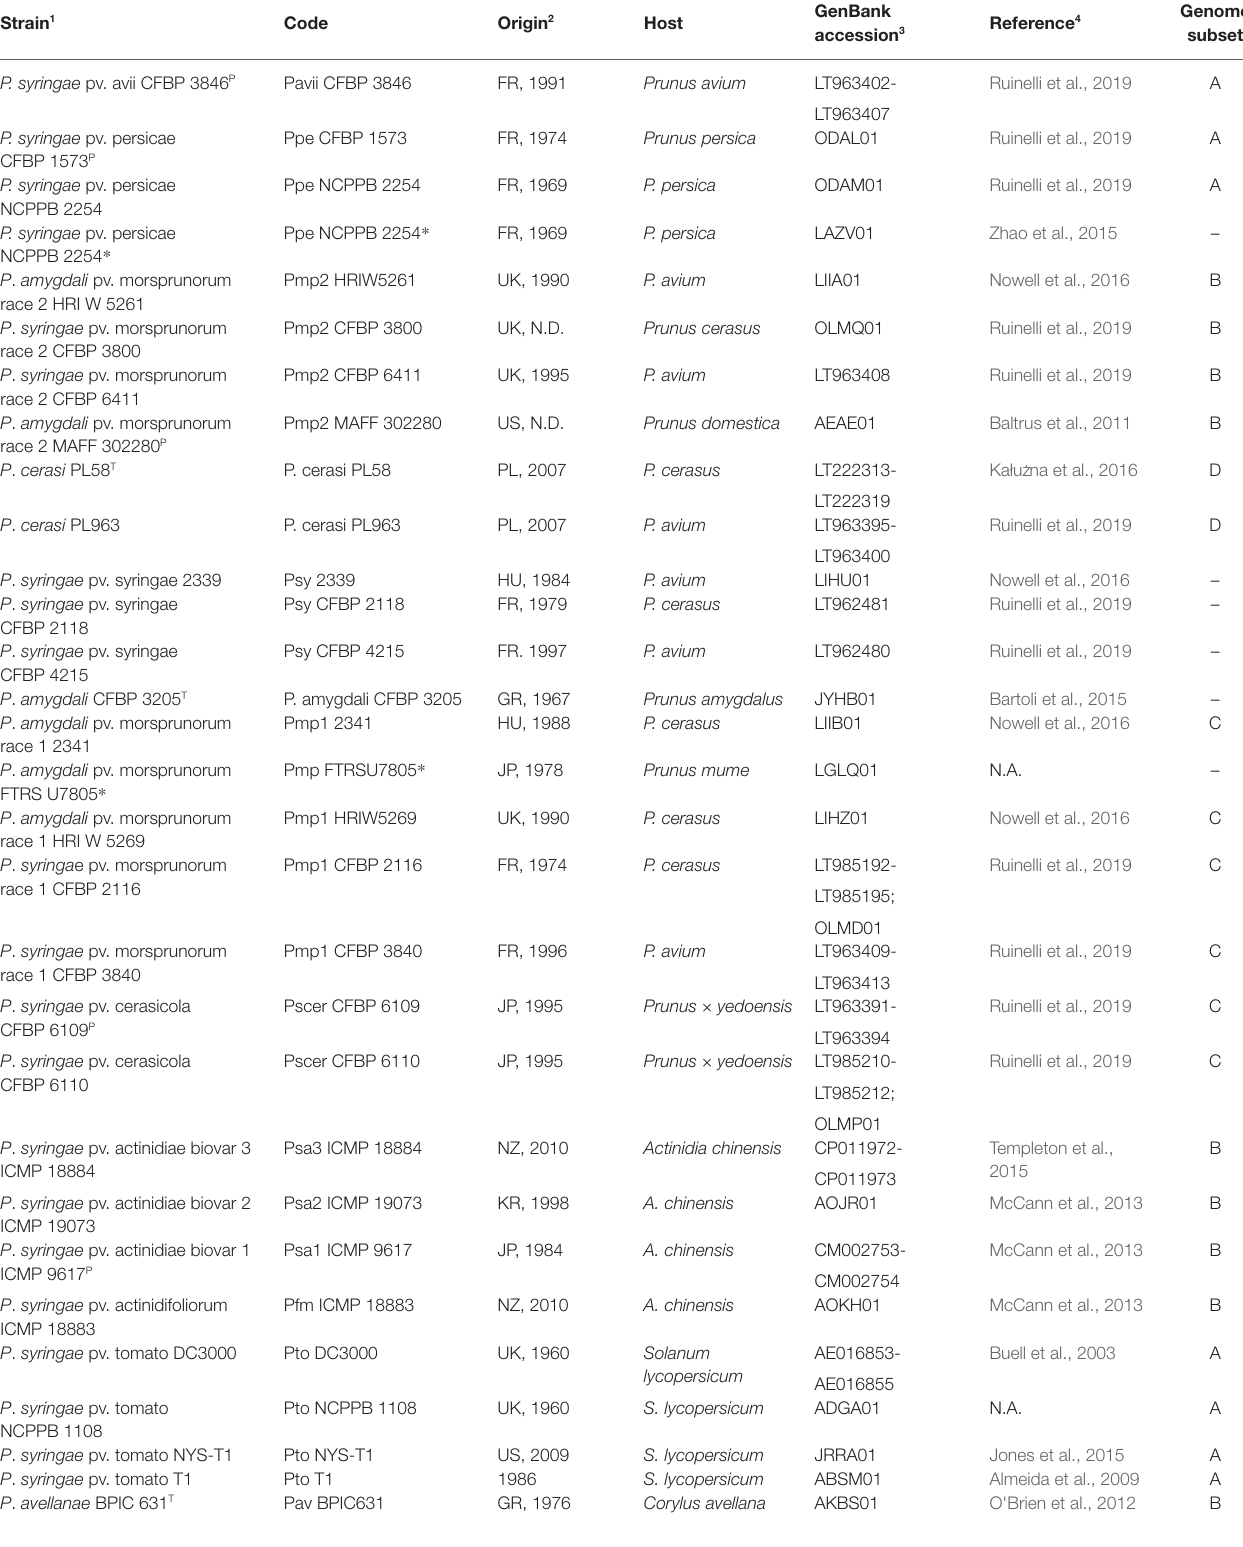
TABLE 1 | List of strains used for this